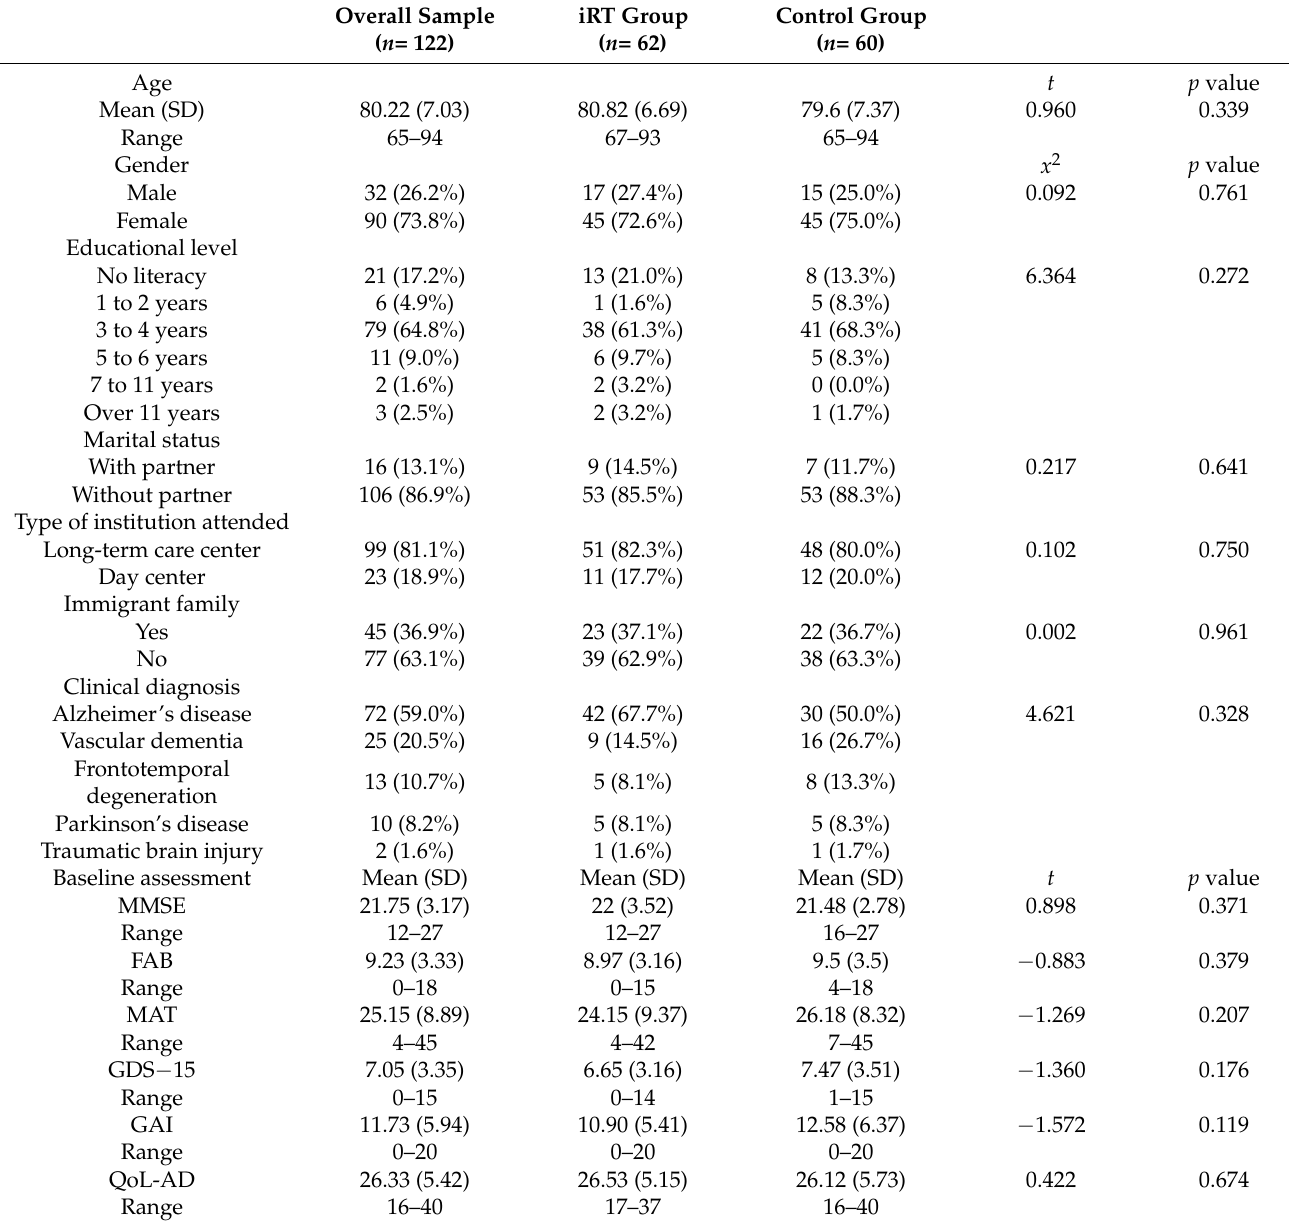
Table 1. Sociodemographic and clinical characteristics of the sample. Results of between-group comparisons at